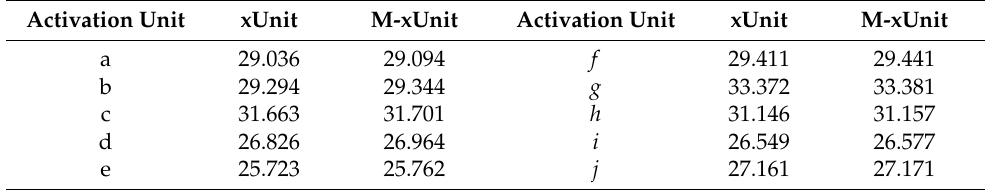
Table 3. The PSNR (dB) comparison of xUnit and M-xUnit with speckle noise level L = 10.